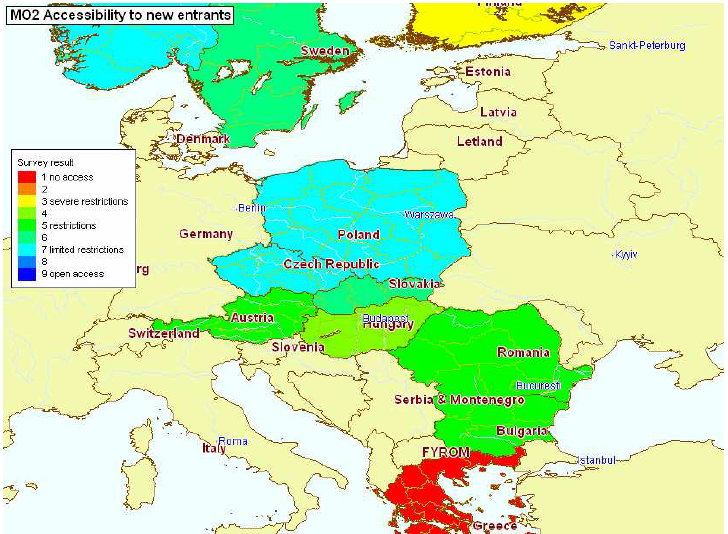
Figure 2. Thematic map for requirement MO2 (Accessibility to new entrants)